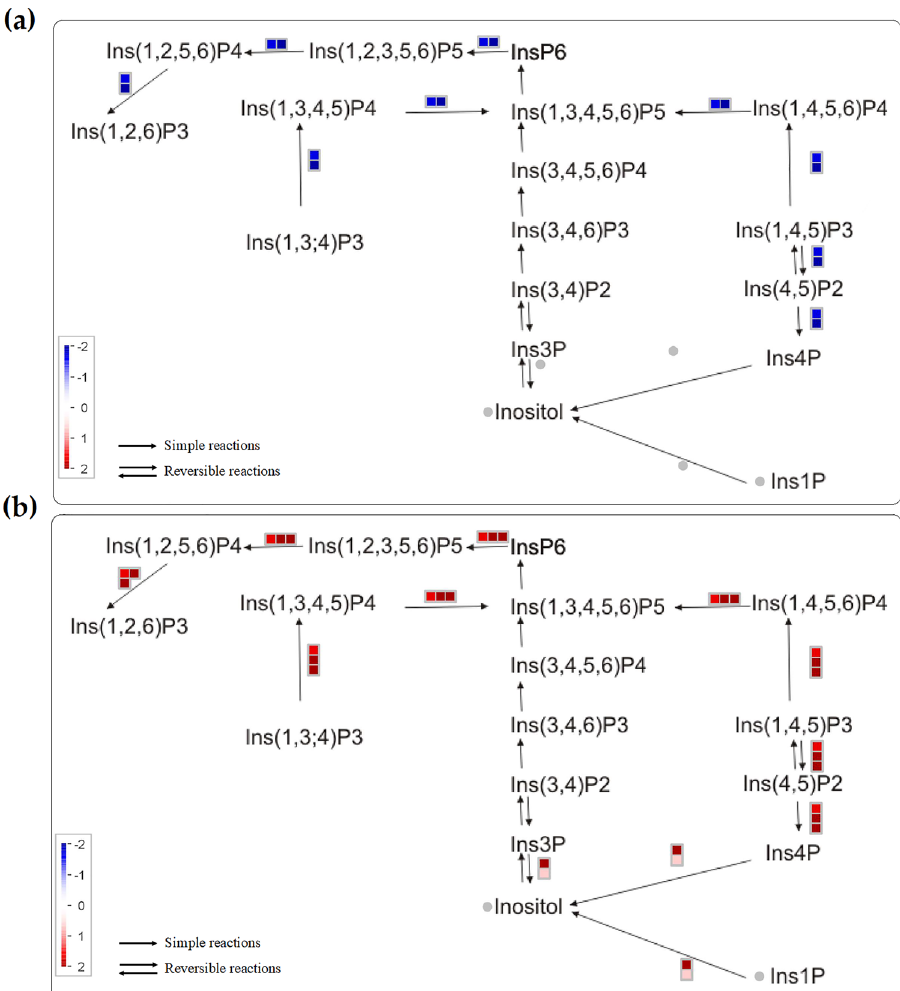
Figure 4. The expression levels of genes from inositol phosphate metabolism among DEGs in ( a ) Gladiator and ( b ) Iwa. Genes are represented by square blocks (expressed as log2 fold change), with up and downregulation are marked by red and blue, respectively. Grey circles indicate that none of the expressed genes could be assigned to the respective class. Ins1P, inositol-1-phosphate; Ins3P, inositol 3-phosphate; Ins4P, inositol-4-phosphate; Ins(1,4,5)P3, inositol 1,4,5-trisphosphate; Ins(4,5)P2, inositol 4,5-bisphosphate; Ins(1,4,5,6)P4, Inositol 1,4,5,6-tetrakisphosphate; Ins(3,4)P2, inositol 3,4-bisphosphate; Ins(3,4,6)P3, inositol 3,4,6-trisphosphate; Ins(3,4,5,6)P4, Inositol 3,4,5,6-tetrakissphosphate; Ins(1,3,4,5,6)P5, Inositol 1,3,4,5,6-pentakisphosphate; Ins(1,3,4)P3, Inositol 1,3,4-trisphosphate; Ins(1,3,4,5)P4, Inositol 1,3,4,5-tetrakisphosphate; InsP6, Myo- inositol hexaphosphate; Ins(1,2,3,5,6)P5, Inositol 1,2,3,5,6-pentaphosphate; Ins(1,2,5,6)P4, Inositol-1,2,5,6- tetraphosphate; Ins(1,2,6)P3, Inositol